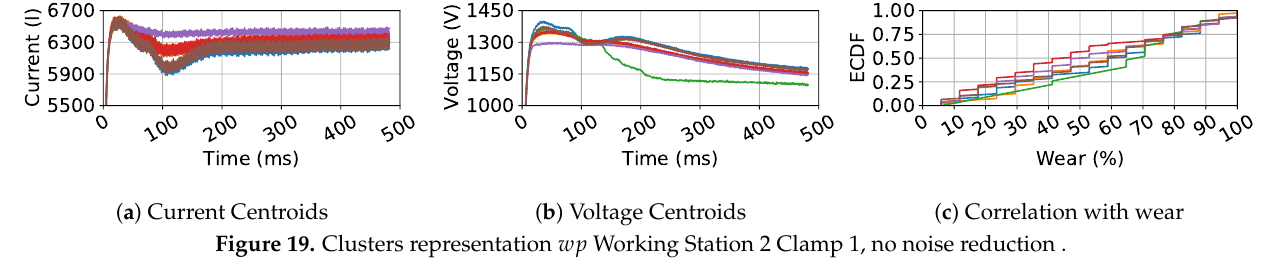
Figure 19. Clusters representation wp Working Station 2 Clamp 1, no noise reduction